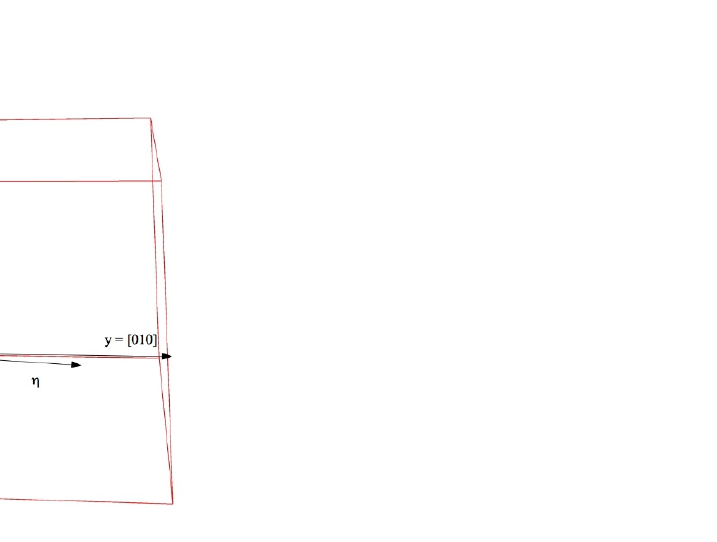
Figure 1. The frame S is referred to the crystallographic axes of the cubic crystal with axes (a,a,a); the frame Σ corresponds to the principal axes of the Optic Indicatrix. In absence of stress, since the optical indicatrix is a sphere we may assume S = Σ